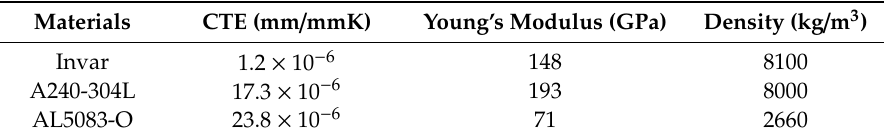
Table 1. Mechanical properties of cryogenic materials (at room